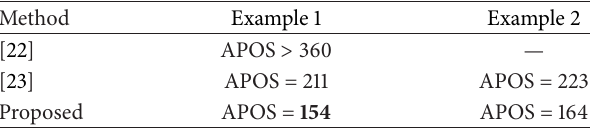
Table 1: Comparisons in terms of APOS for Examples 1 and